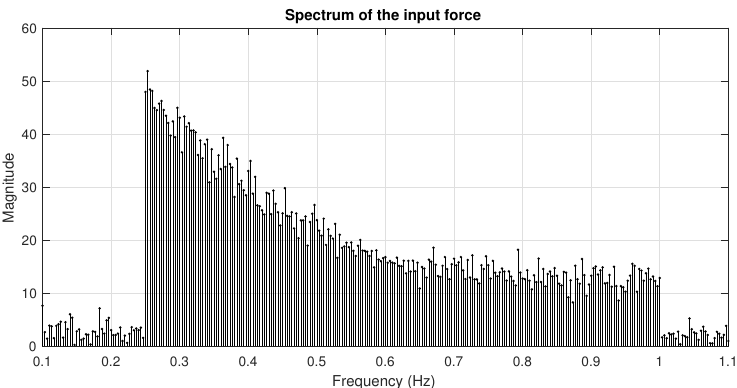
Figure 10. Spectrum of the input force: “white” (flat) multisine.